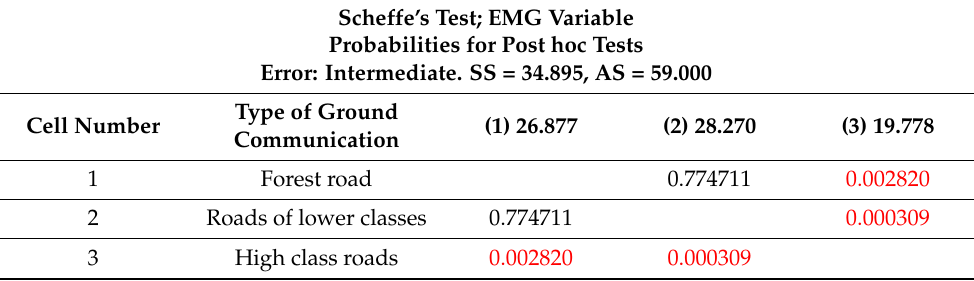
Table 7. Post hoc test to analyze the variance of muscle load values depending on the type of com- munication when driving the timber truck. The red text indicates statistical significance.